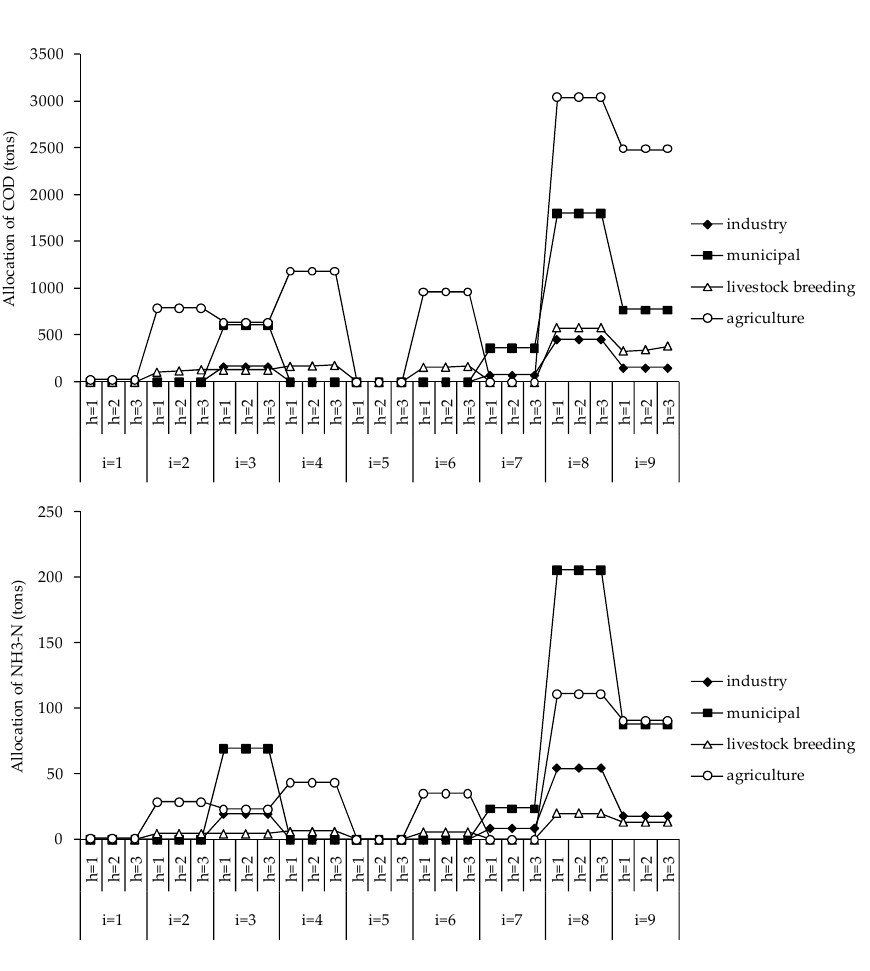
Figure 5. Allocation amounts of the controlled pollutants in Period 2.